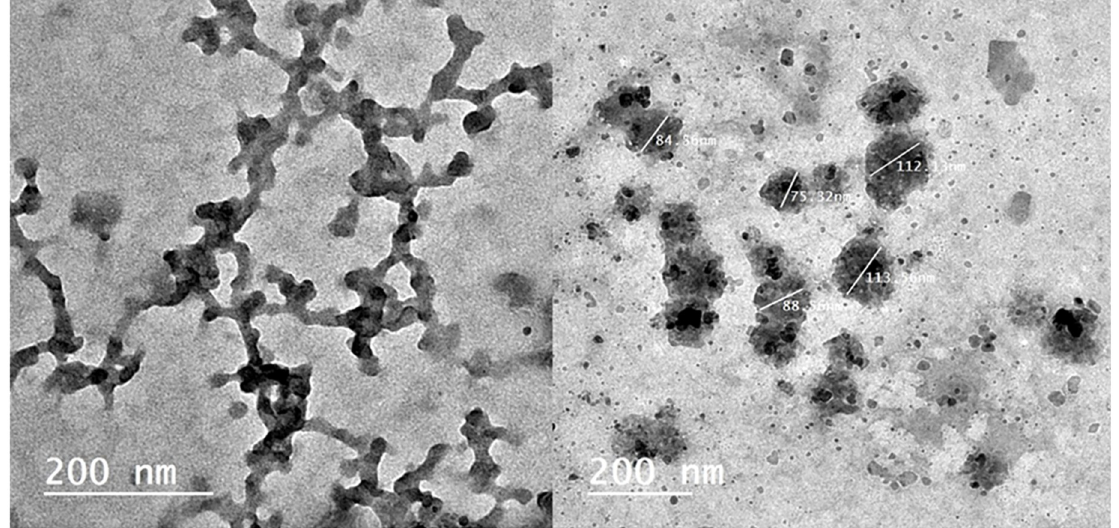
Fig 10. TEM images of the effect of biologically active silver nitrate on Candida albicans isolates (image contains disrupted cells).